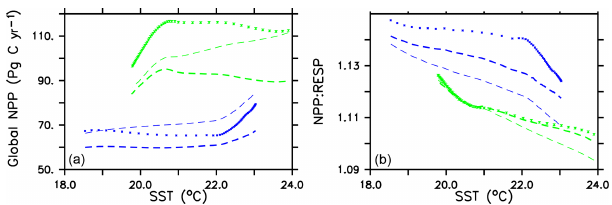
Figure A1. Globally integrated annual net primary production and average sea surface temperature transient response in WARMING icehouse (blue) and COOLING greenhouse (green) experiments from start to finish of each simulation (a) . Globally integrated an- nual NPP divided by gross respiration in the upper 130m and av- erage sea surface temperature, from start to finish of each simula- tion (b) . Dotted lines represent the MIXED model, thin dashed lines represent the NOCACO3TR model, and thick dashed lines repre- sent the CAL